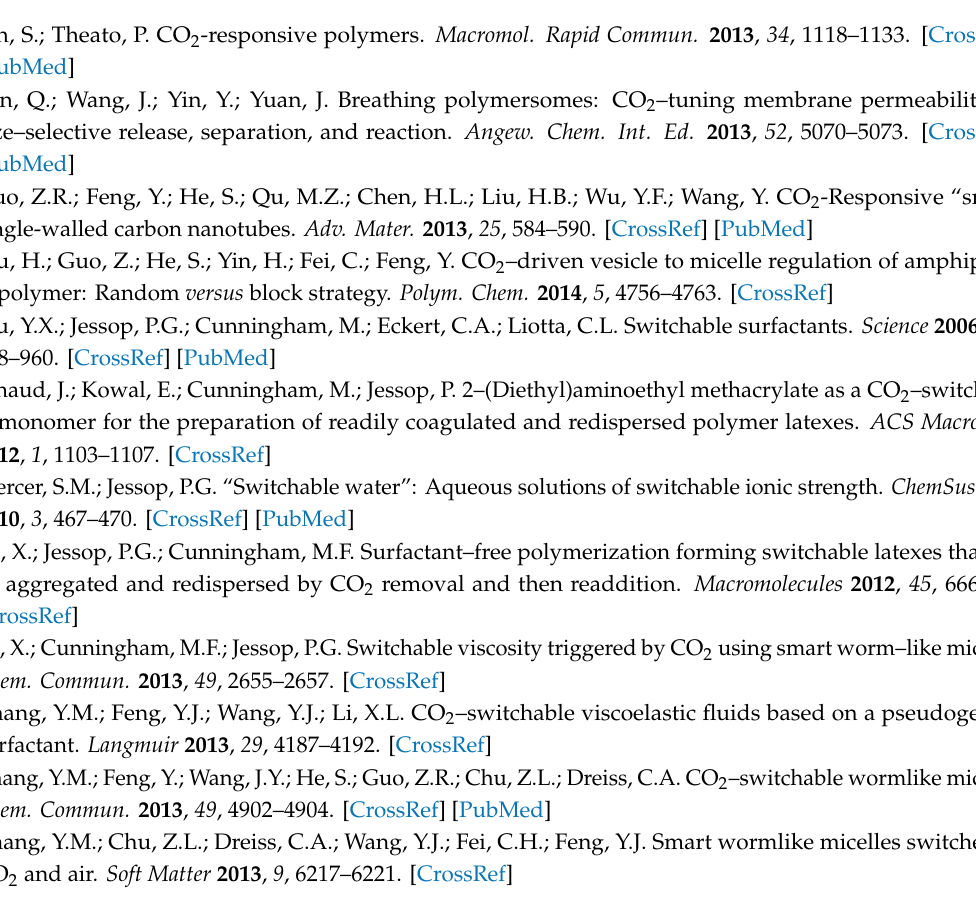
Figure S1: 1H NMR spectrum of polymer 1. CClD3 was used as solvent, Figure S2: 1H NMR spectrum of polymer 2. CClD3 was used as solvent. Figure S3: 1H NMR spectrum of polymer 3. CClD3 was used as solvent, Figure S4: 1H NMR spectrum of protonated polymer 2 by CO2 and H2O. CD3OD was used as solvent. Author Contributions: Investigation, Y.J. and T.Z.; methodology, Y.J. and T.Z.; project administration, Z.Y.